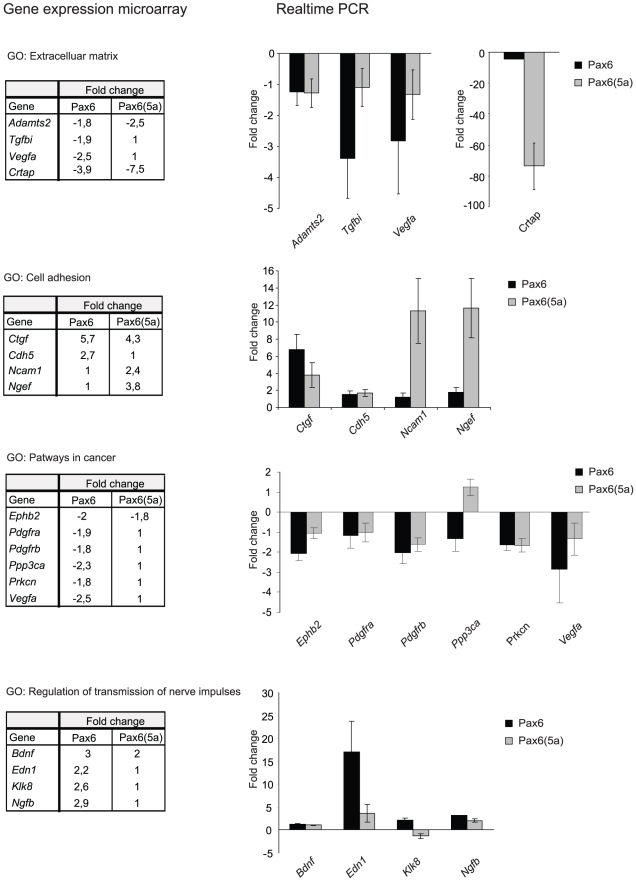
Real time quantitative PCR verifies differentially regulated genes in both the FlpIn-3T3 Pax6 and Pax6(5a) cell lines.Primers were designed for genes representative for the gene ontology terms “Extracellular matrix” (Adamts2, Tgfbi, Vegfa and Crtap), “Cell adhesion” (Ctgf, Cdh5, Ncam1 and Ngef), “Pathways in cancer” (Ephb2, Pdgfra, Pdgfrb, Ppp3ca, Prkcn and Vegfa) and “Regulation of transmission of nerve impulses” (Bdnf, Edn1, Klk8 and Ngfb) and used in qPCR. Results are means of three independent experiments and are presented as fold change in cDNA concentrations in the FlpIn-3T3 Pax6 and Pax6(5a) cell lines compared to the FlpIn-3T3 control cell line, after normalization against two housekeeping genes. The fold change values obtained for the same genes in the Illumina gene expression microarray are given in the table to the left of each graph for comparison.